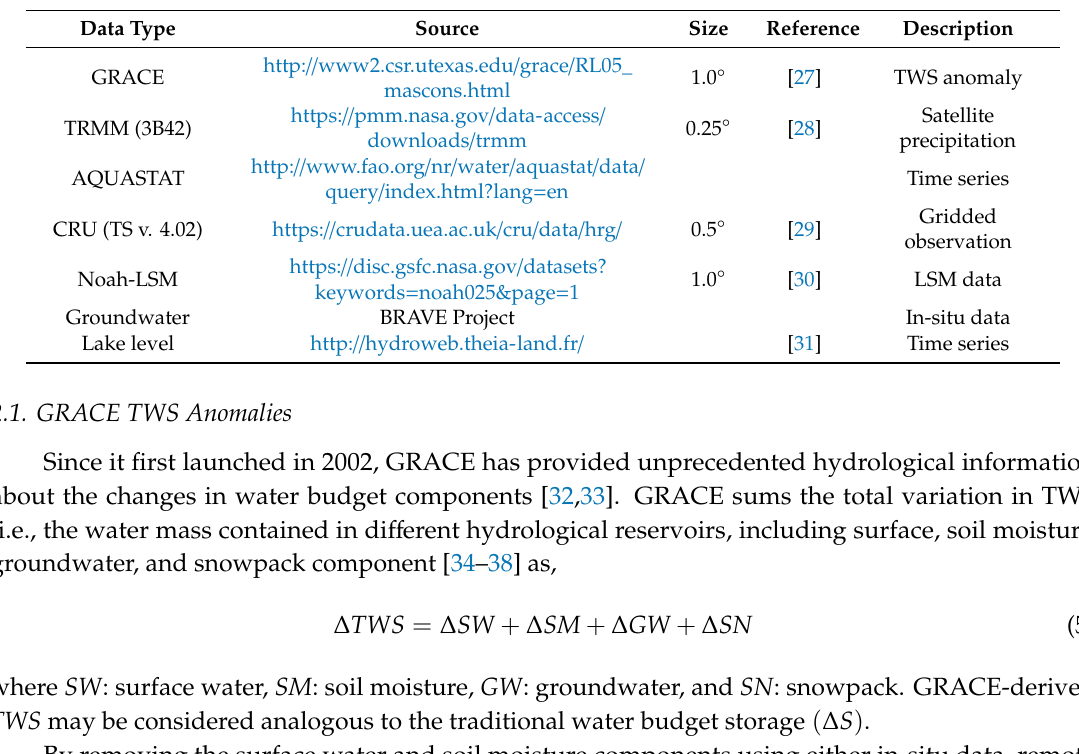
Table 3. Sources and information about the utilized